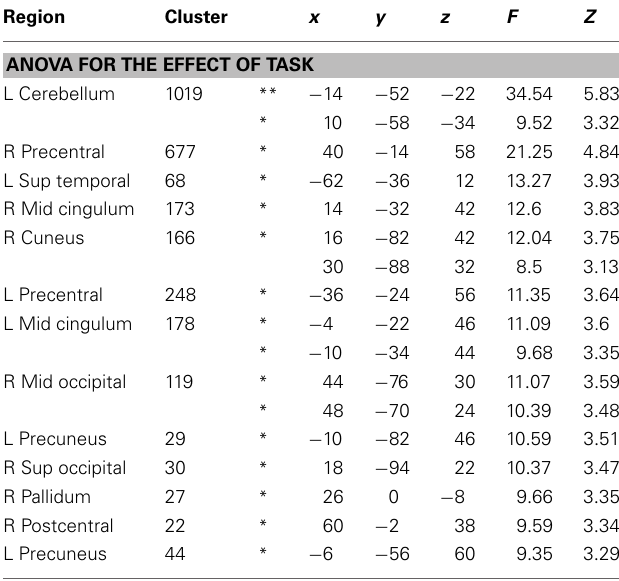
Table 3 | Regions showing significant differences between tasks in One-Way repeated-measure ANOVA, at least p < 0 . 001